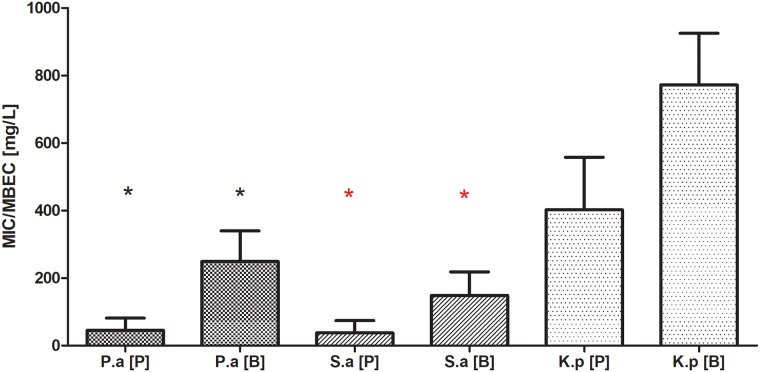
Minimal Inhibitory Concentration [MIC] and Minimal Biofilm Eradication Concentration [MBEC] of gentamicin towards planktonic [P] and biofilm-forming [B] cells of P.aeruginosa [P.a], S.aureus [S.a.], K.pneumoniae [K.p.].Asterisks show statistical significance [K-W test, p<0.05] between results obtained for P vs. B of particular microbial species.